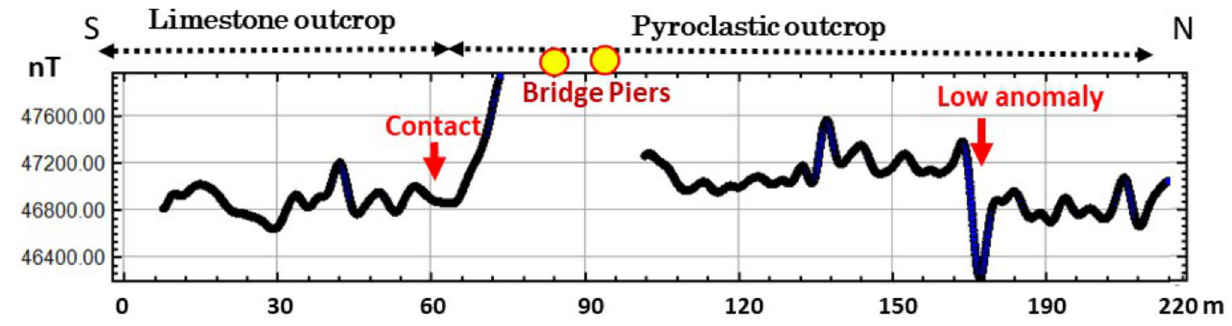
Figure 9: Magnetic data along profile P5. Note the significant variation of magnetic values across the contact between limestone and pyroclastic deposits, and a low magnetic anomaly location at station 185 m.